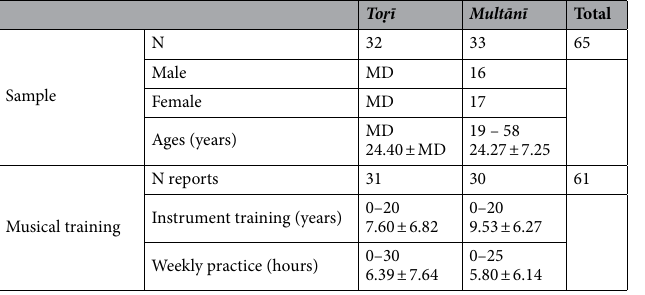
Table 1. Demographic information for the participant sample. Years/hours are indicated as range and mean ± SD. MD indicates missing (unavailable)